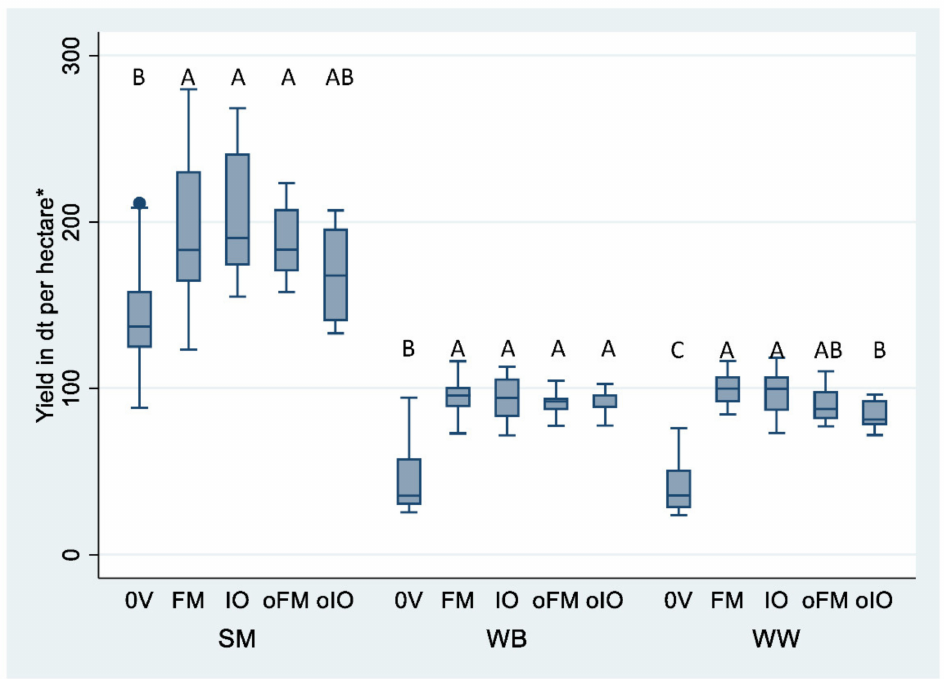
Figure 4. Location and dispersion measures for different crop yields grouped by level of fertilizer application ( n = 297). Levels of fertilization: 0V = no fertilization ( n = 3 × 27); FM = farm manager variant ( n = 3 × 27), IO = model variant ( n = 3 × 27); oFM = FM + organic fertilization ( n = 3 × 9); oIO = IO + organic fertilization ( n = 3 × 9). Within a crop (SM, WB, and WW), the following applied: means sharing a letter in the group were not significantly different at the 5% level. * For SM, yield refers to dry matter; for WB and WW, yield was corrected to 86% of dry-matter